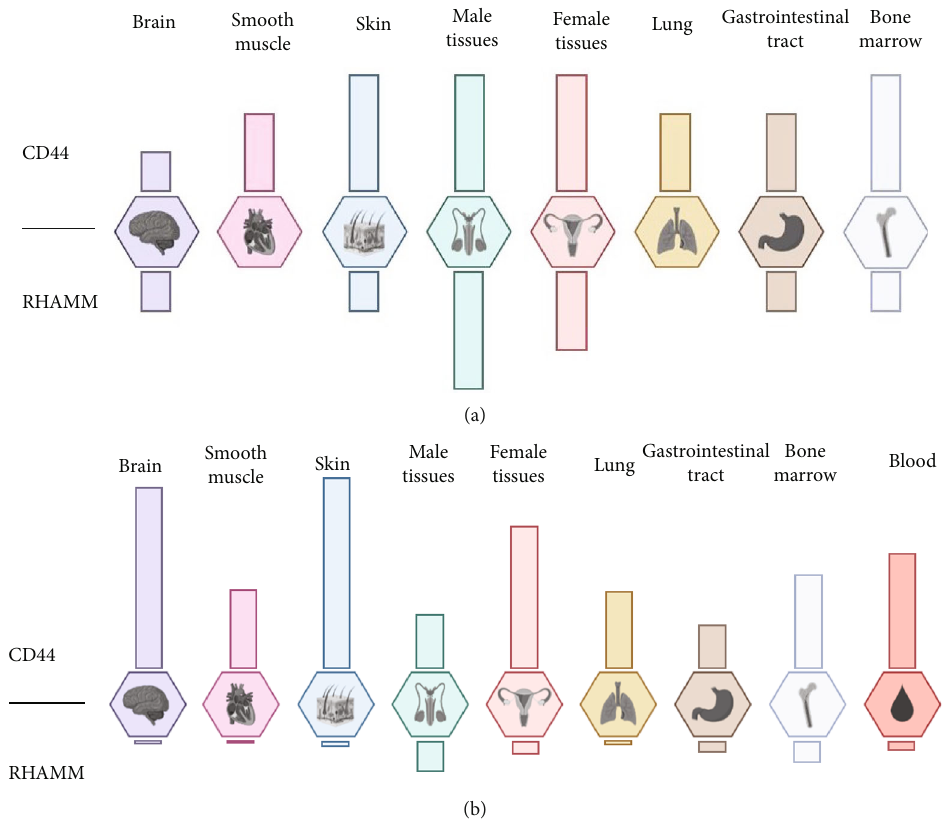
Figure 1: Protein (a) and mRNA (b) expression of CD44. Prepared on the basis of data from the Human Protein Atlas [37]. Protein expression reported with the units: not detected, low, medium, and high. mRNA expression reported as normalized expression (NX) combined from three transcriptomics datasets (HPA, GTEx, and FANTOM5). Created with